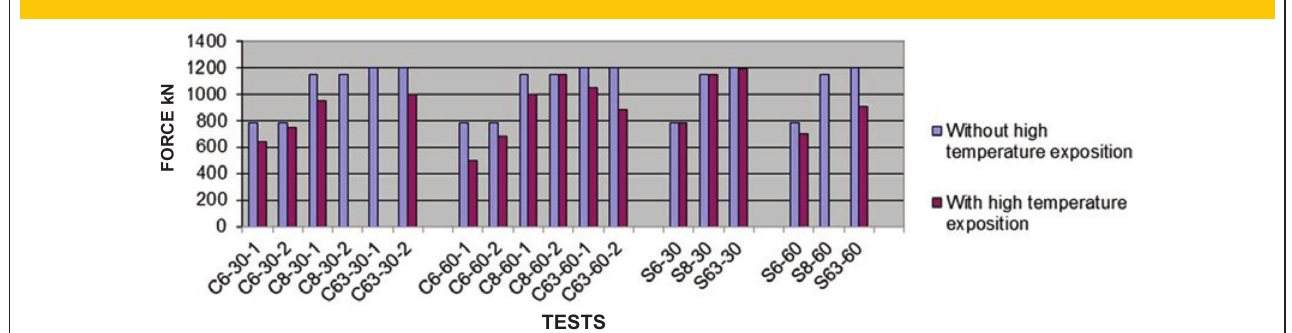
Figure 6 – Maximum axial stress: columns at room temperatures X columns after exposure to high temperatures